Question: In a single sentence, describe what this figure presents.
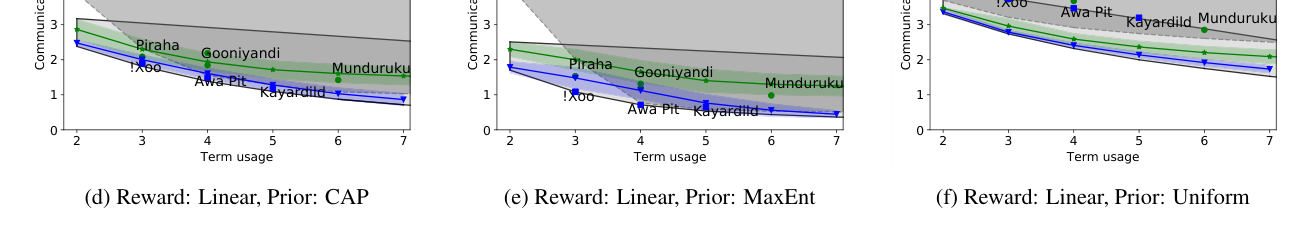
Answer: Term usage vs communication cost. Note that our agents are not restricted to model the words as Gaussian distribu- tions and can create other probability distributions. This explains why the line goes below the convex hull, for 2 terms, which was computed assuming Gaussian distributions. We plot the numeral systems from the human languages presented Table 1 and since many of them are very similar we only get a few distinct points for human languages in the figure.